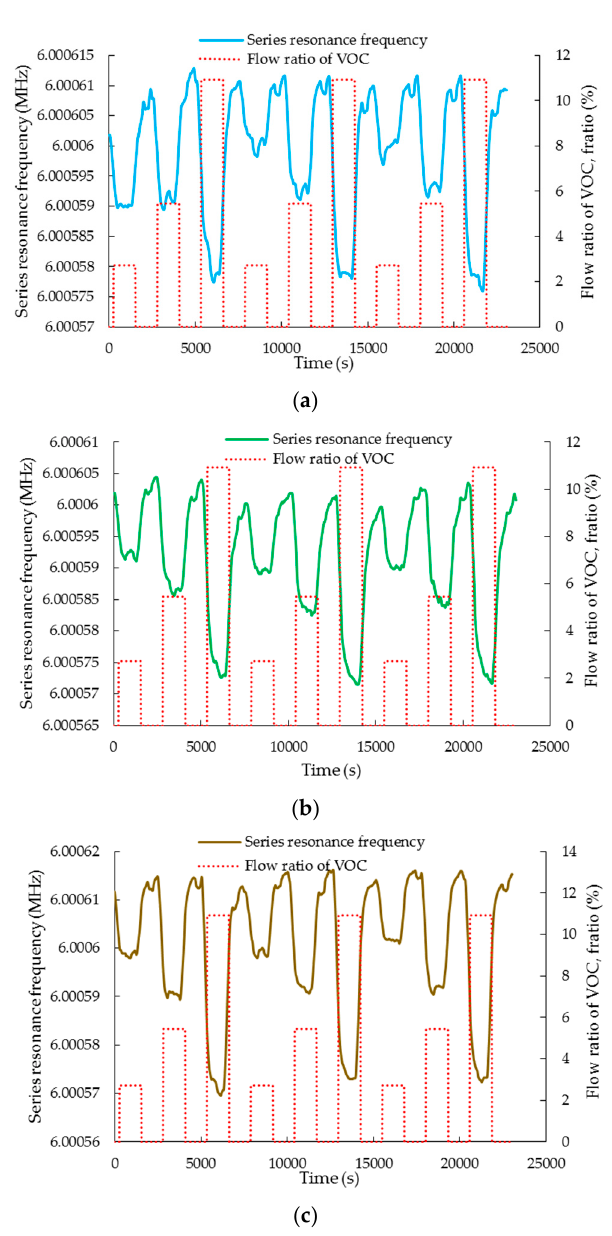
Figure 7. The dynamic response of the sensor’s series resonant frequency ( a )–( c ) towards flow ratios of 2.73%, 5.45%, and 10.91% of ethanol, acetic acid, and ethyl acetate VOC molecules, respectively. The flow ratio variation of the VOC is shown in the secondary vertical axis. A value of V ratio = 0 indicates the absence of VOC molecules in the flow.